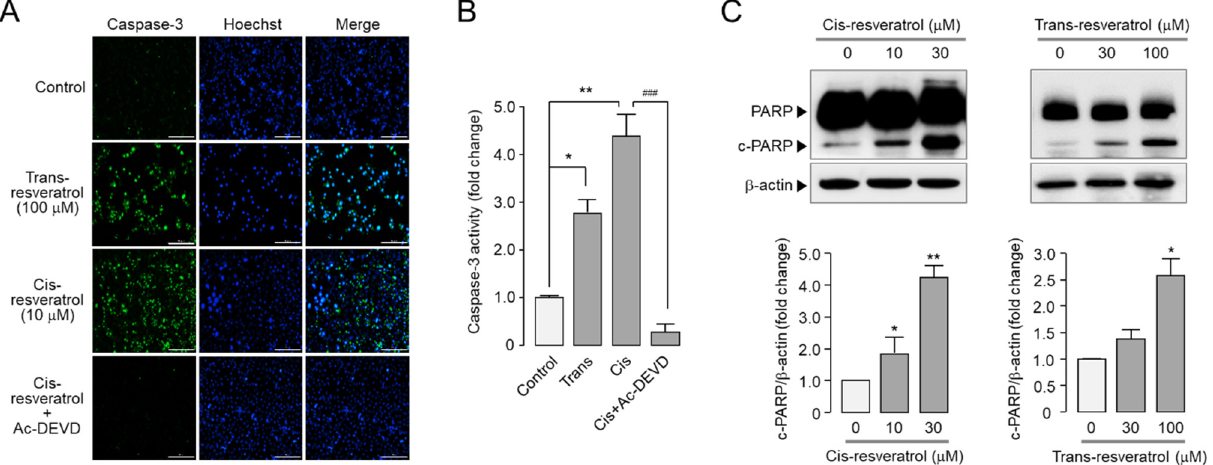
Figure 6. Effects of cis - and trans -resveratrol on caspase-3 activity and PARP cleavage in PC-3 cells ( A ) Images were taken after 24 h treatment with cis - and trans -resveratrol. Cells were treated with the caspase-3 substrate (green) and Hoechst 33,342 (blue) for 20 min before image acquisition. Scale bars represent 200 μ m. ( B ) PC-3 cells were treated with cis -resveratrol at 10 μ M in the presence or absence of 10 μ M Ac-DEVD-CHO and trans -resveratrol at 100 μ M for 24 h. Caspase-3 activity was measured 20 min after treatment of 2 μ M caspase-3 substrate (mean ± S.D., n = 3). ( C ) Cells were treated with indicated concentrations of cis - and trans -resveratrol for 24 h and immunoblot analysis was used to measure the expression level of PARP, cleaved-PARP, and β -actin. Cleaved-PARP protein intensities were normalized to those of β -actin (mean ± S.D., n = 3). * p < 0.05, ** p < 0.01 vs. control, ### p < 0.001 vs. cis +Ac-DEVD.